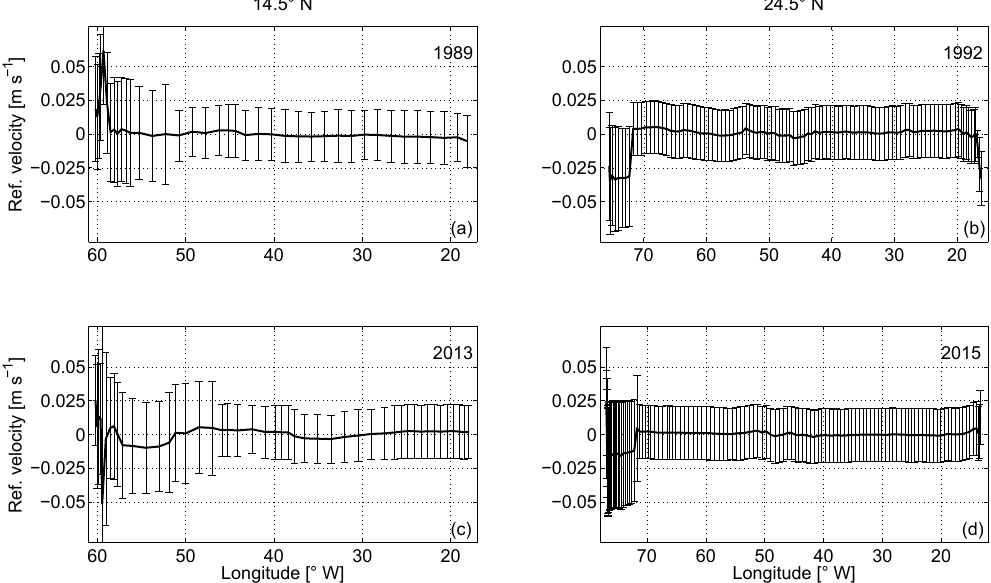
Figure 8. Final adjustments to the reference velocity with uncertainties along 14.5 ◦ N in (a) 1989 and (c) 2013 and along 24.5 ◦ N in (b) 1992 and (d) 2015. Note that except for the section along 14.5 ◦ N in 2013, the initial reference velocity is 0; therefore, the final adjustments in (a) , (b) , and (d) are equivalent to the final reference velocity.